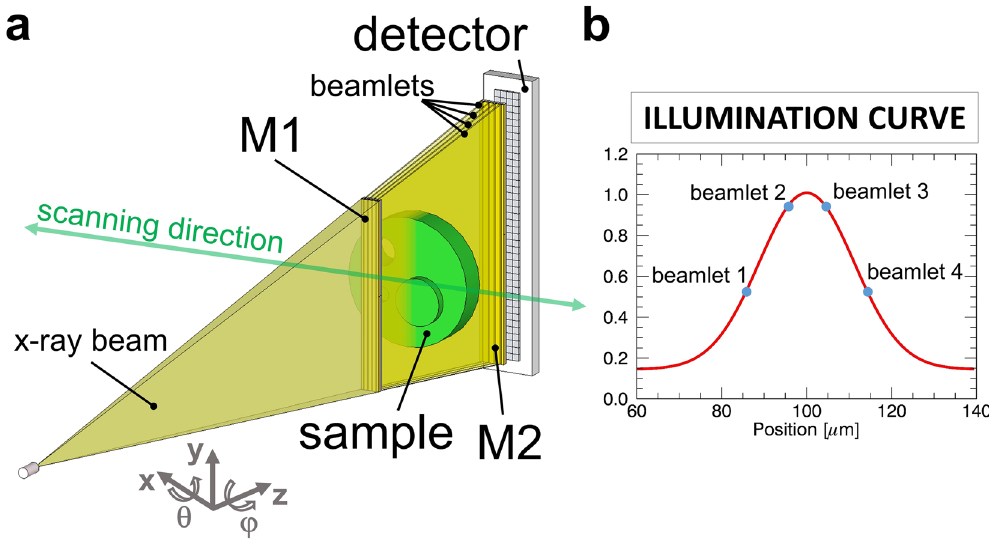
Figure 1. Schematic of the imaging system. Schematic view of the setup. The x-ray beam is shaped by the asymmetric pre-sample mask (M1) in several beamlets, realising different alignments with the apertures on the